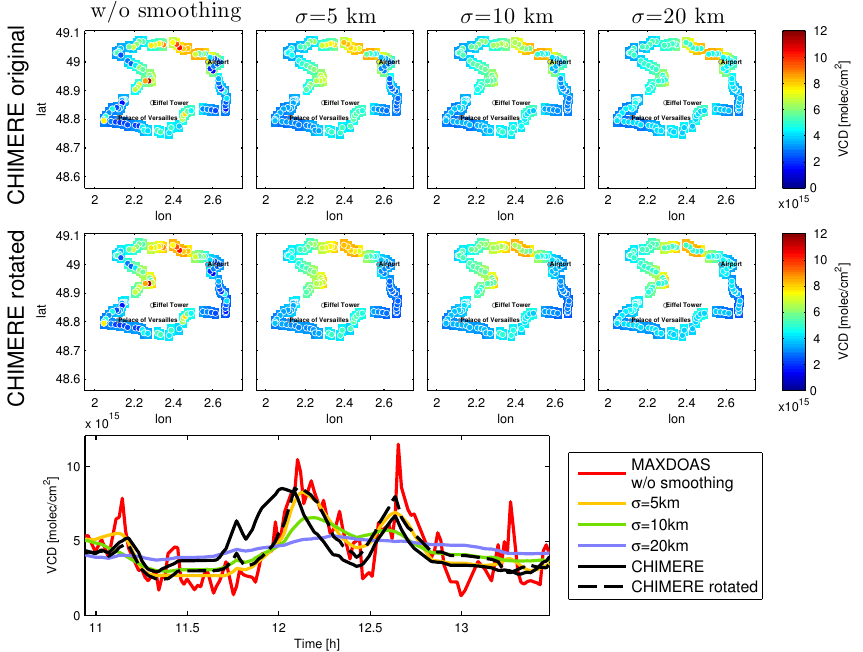
Figure 9. Top: comparison of the car-MAX-DOAS results (small circles) with coincident original or rotated CHIMERE results (squares) for 21 July 2009. The different plots present car-MAX-DOAS data smoothed by Gaussian functions with different smoothing kernels ( σ ranging from 0 to 20km). Bottom: the same data presented as function of time.